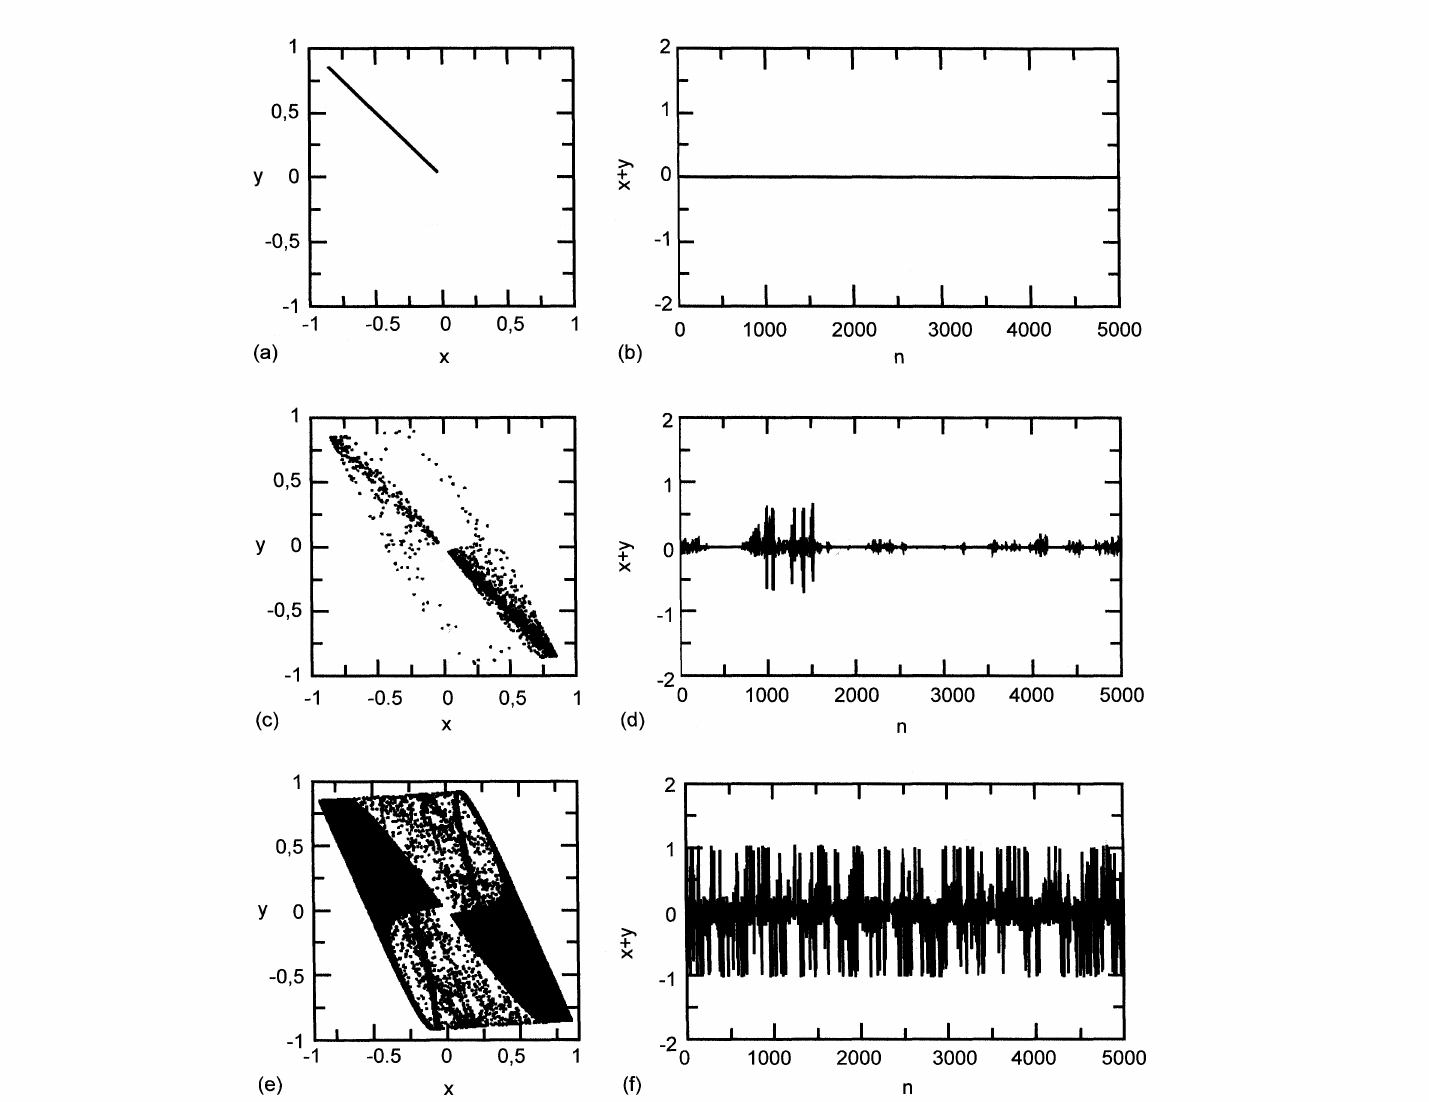
FIGURE 9 The phase portraits and time-series of antiphase oscillations without noise (a,b) and with noise (c,d). In (e,f) there is chaotic oscillations resulted from the blowout bifurcation.